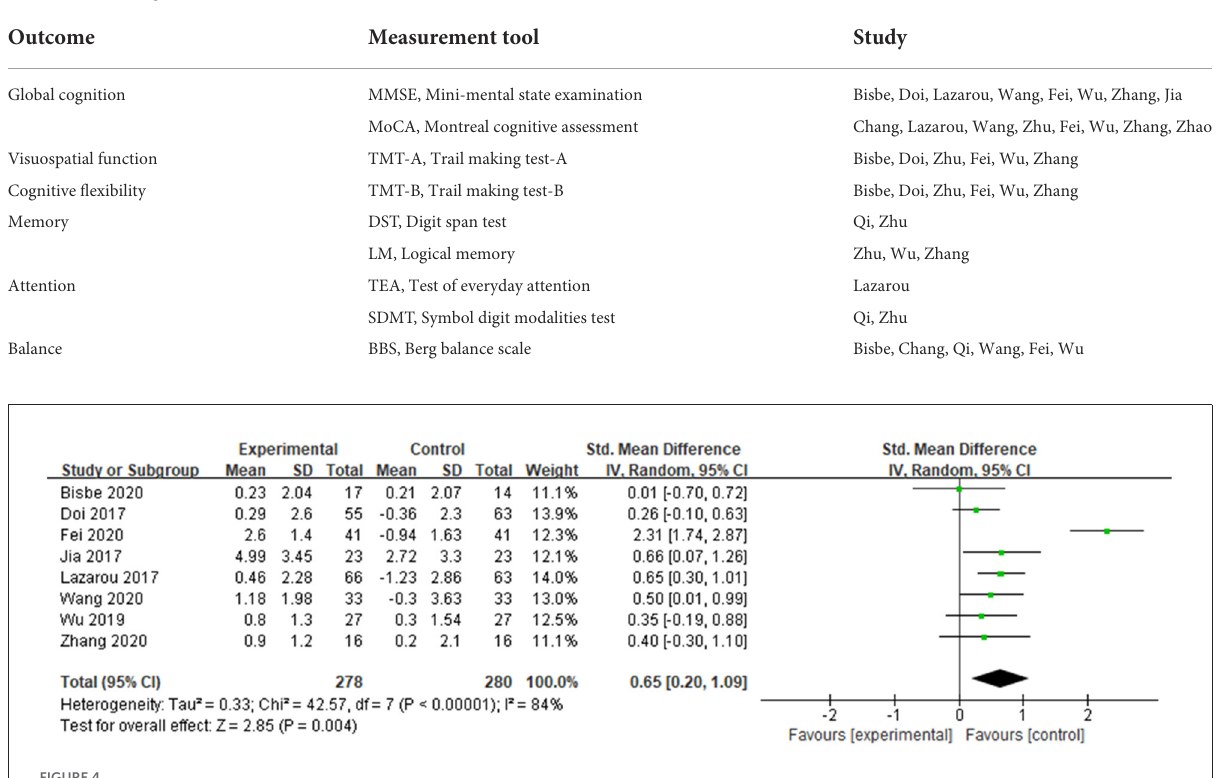
FIGURE4 Effects of dance activities on global cognition (MMSE).